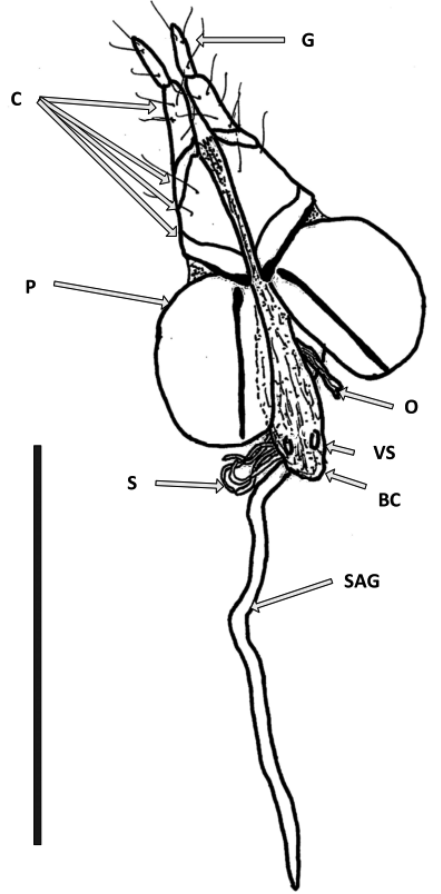
Figure 4. External and internal female genitalia of Eschatoporis styx sp. n. Dorsal view. Ovipositor: G gonostyle; C Coxites; P paraproct. Internal genital tract: O oviduct; VS vaginal sclerites; S spermatheca; BC bursa copulatrix; SAG spermathecal accessory gland. Scale bar: 0.5 mm.